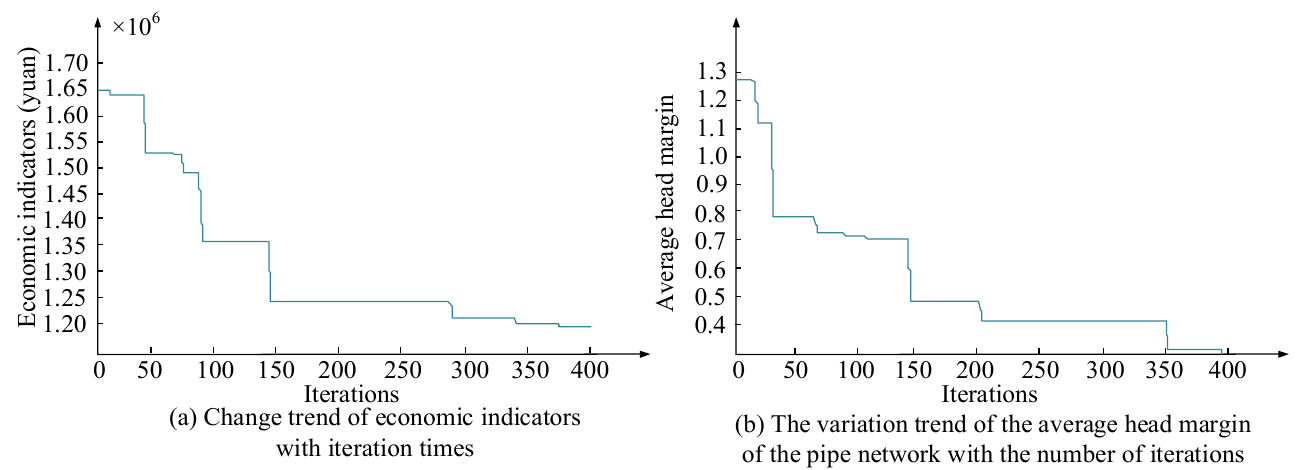
400 (b) The variation trend of the average head margin